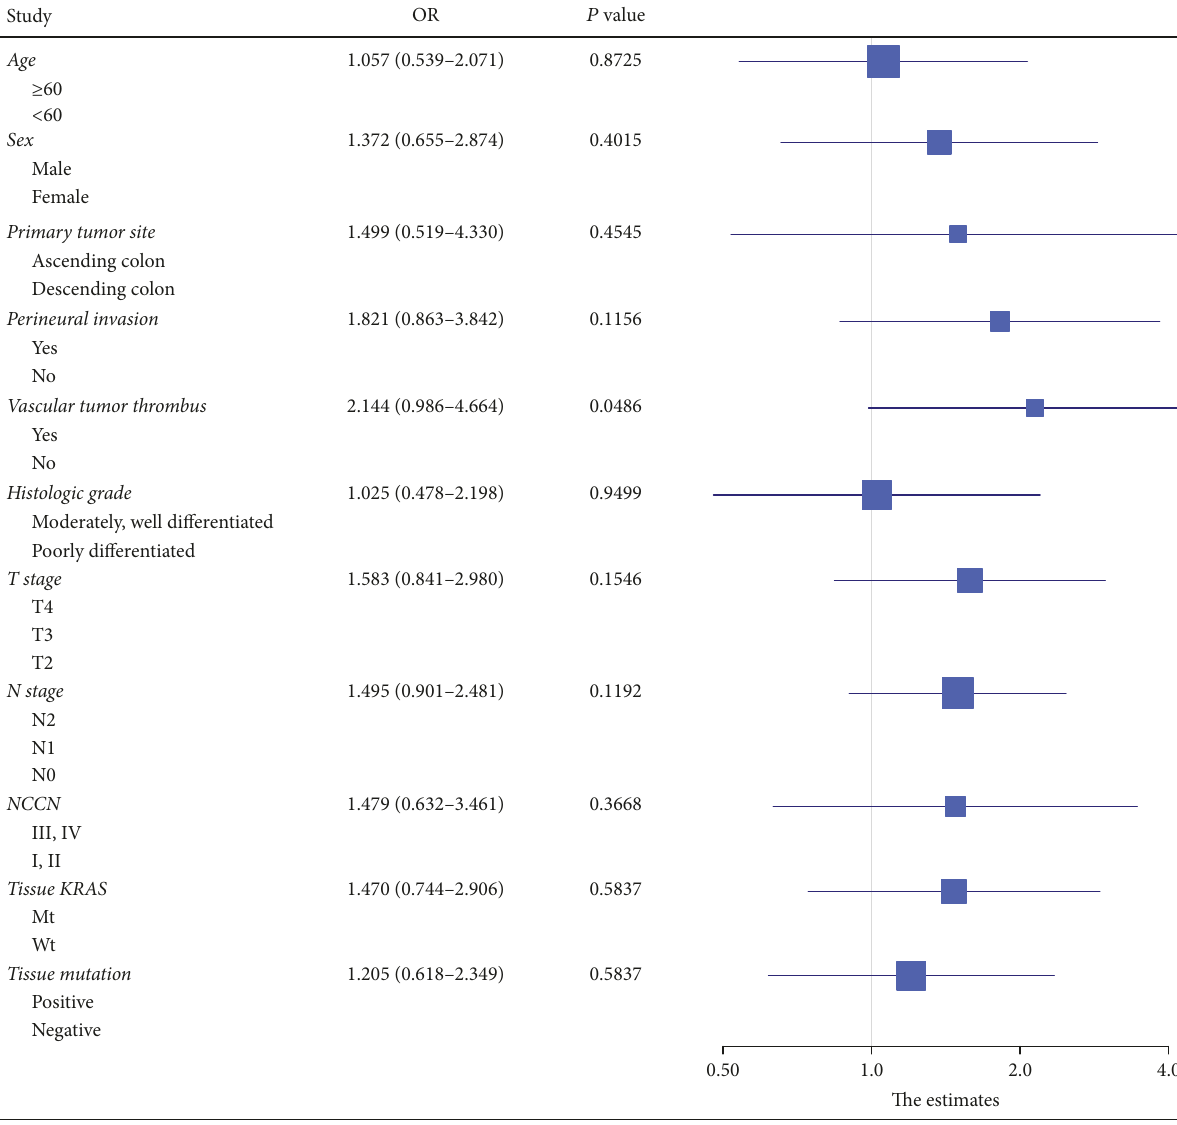
Figure 3: Forrest plot of hazard ratios for DFS of the surgical resection patients. Except for vascular tumor thrombus, none of the other clinicopathologic features showed significant association with poorer